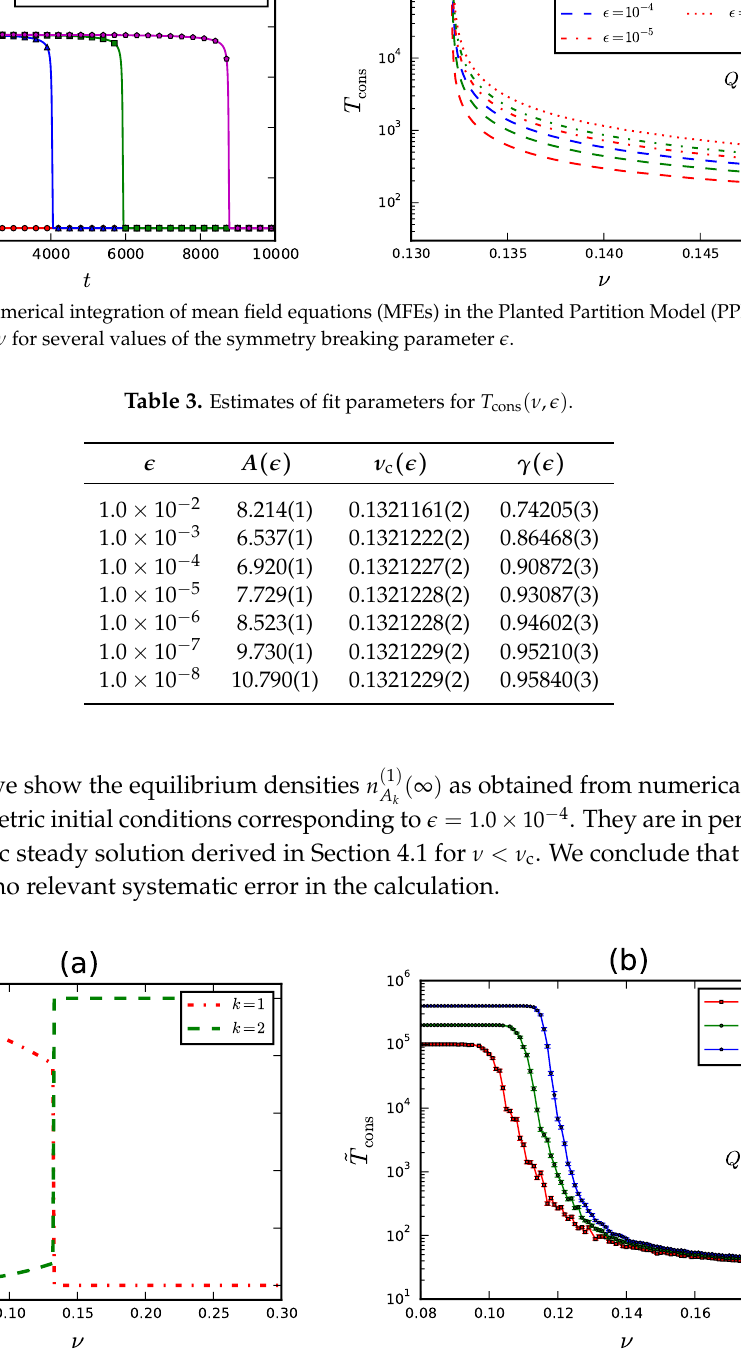
Figure 5. ( a ) Equilibrium densities in C ( 1 ) with initial conditions as in Equation (47); ( b ) Bounded time to consensus from simulations in the PPM with Q =